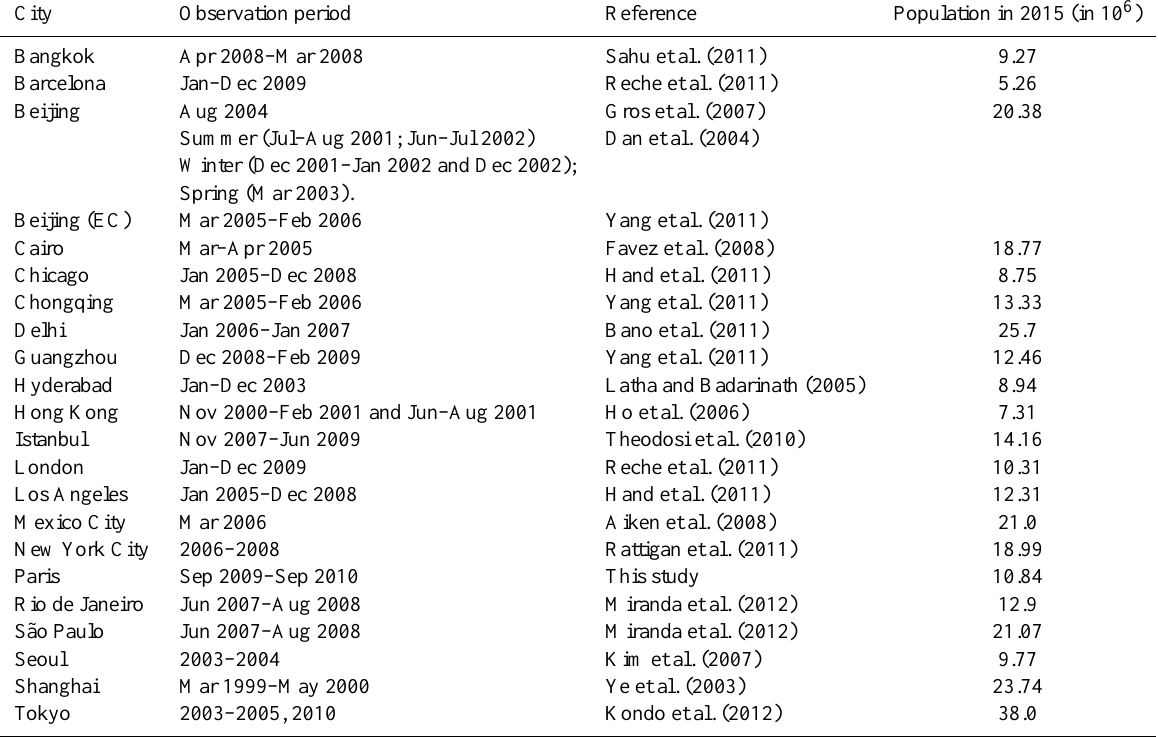
Table 1. Origin of black and elemental carbon data and observation periods used in Fig. 10, and megacity population in year 2015. City Observation